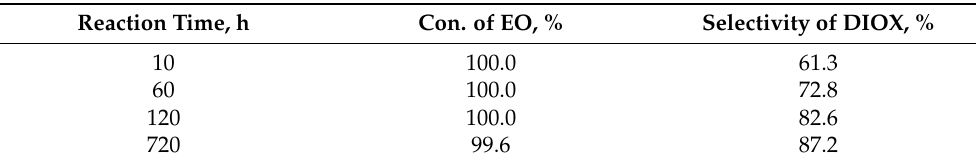
Table 4. Effect of reaction